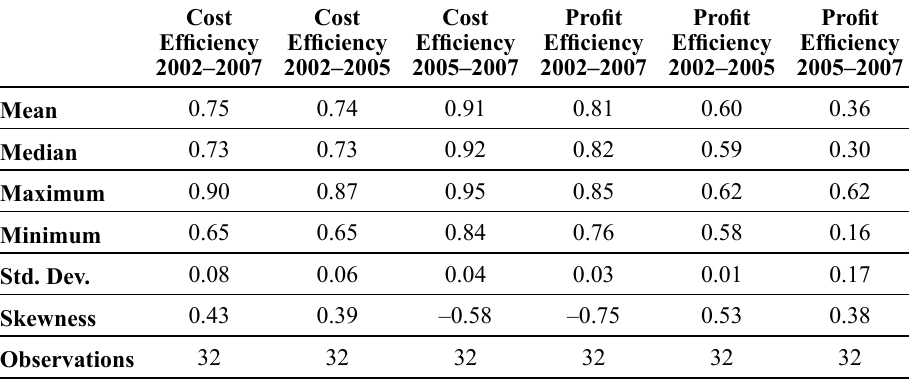
Table 4 . Descriptive Statisti